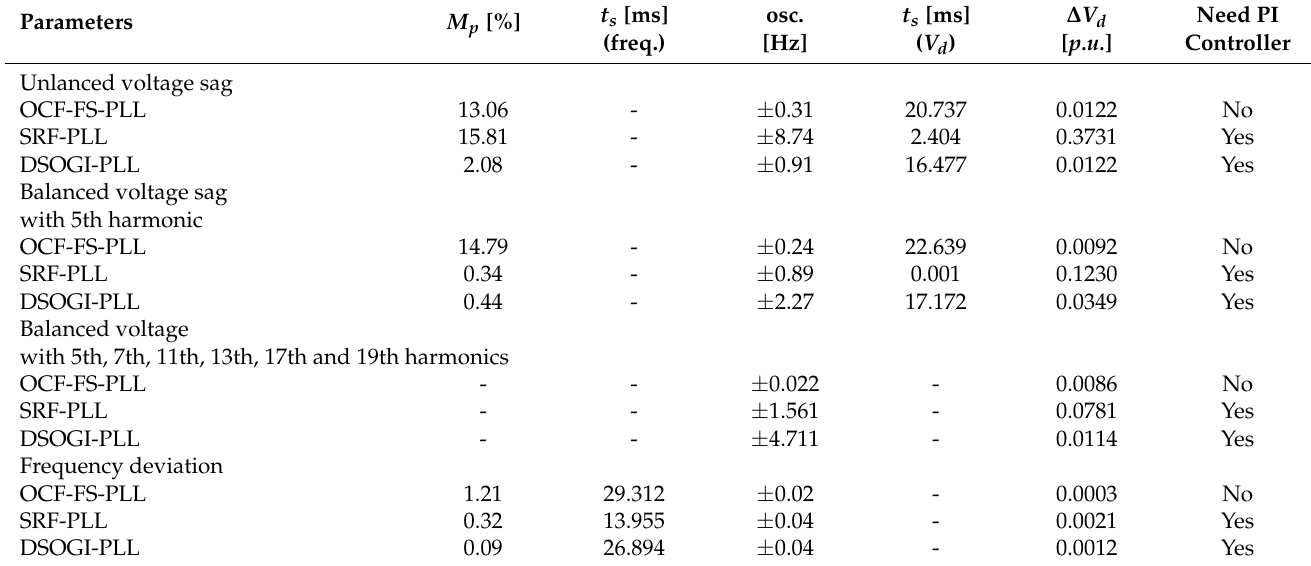
Table 1. Response of the OCF-FS-PLL and dual second order generalized integrator-PLL (DSOGI-PLL).